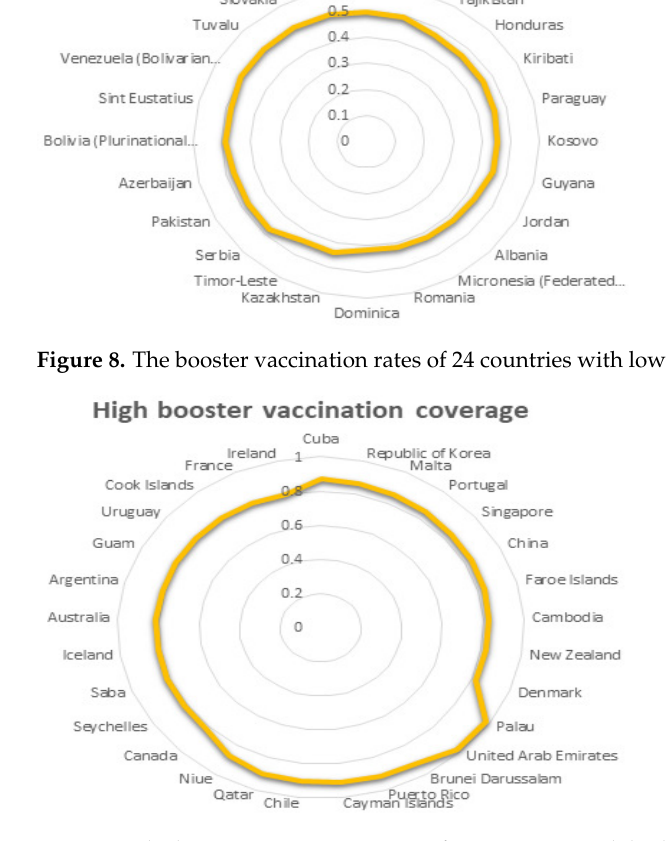
Figure 9. The booster vaccination rates of 29 countries with high vaccination